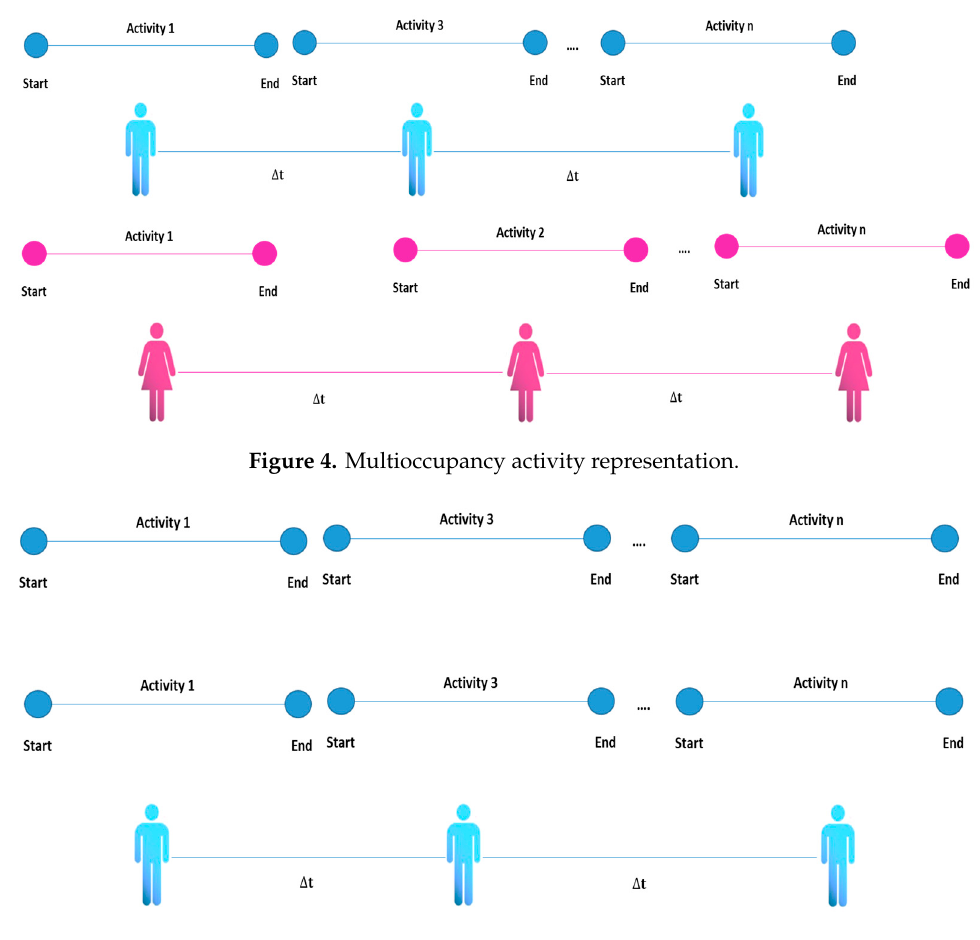
Figure 5. Concurrent activity representation.